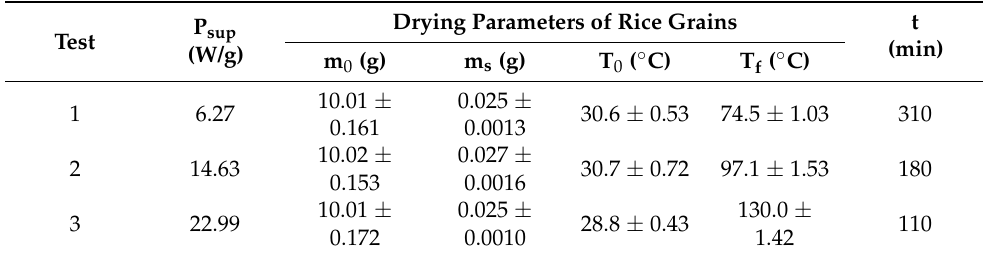
Table 1. Supplied microwave power, drying parameters and total drying time.